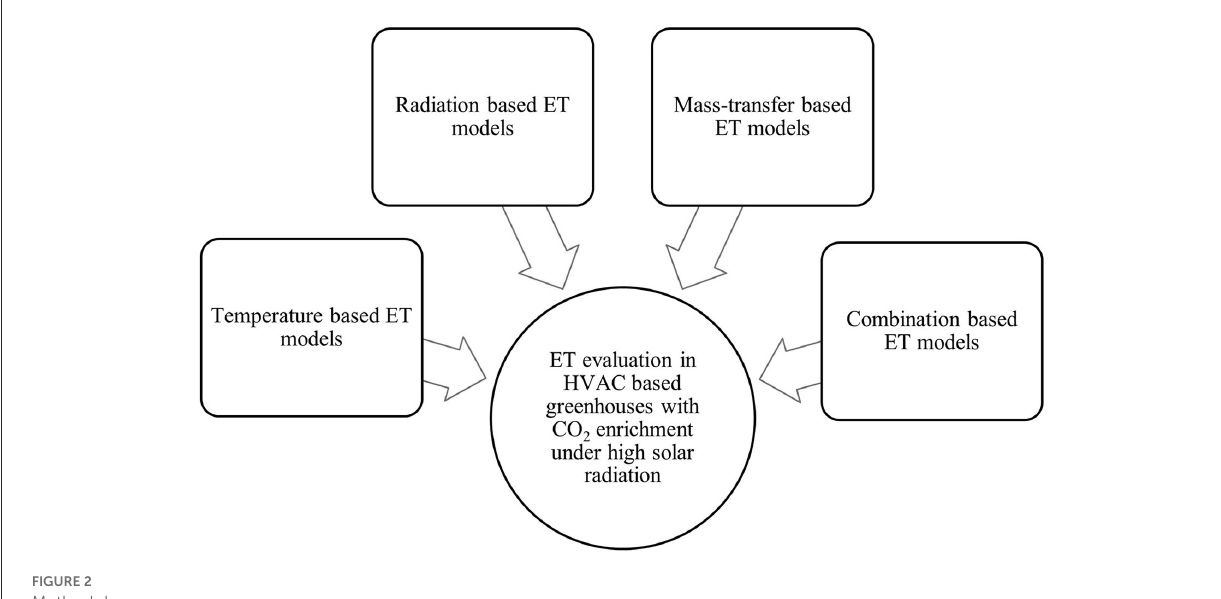
FIGURE2 Methodology.